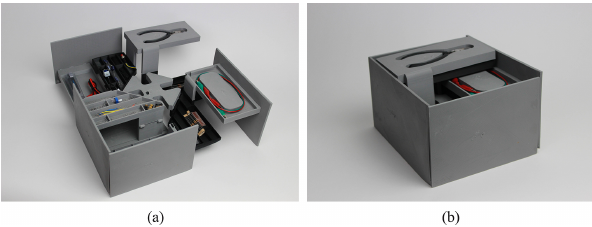
Figure 10. An electrical engineer’s toolbox created from an origami crease pattern and the OPT in (a) the unfolded postion and (b) the folded position. The panel thickness in this model is 0.5 inches.